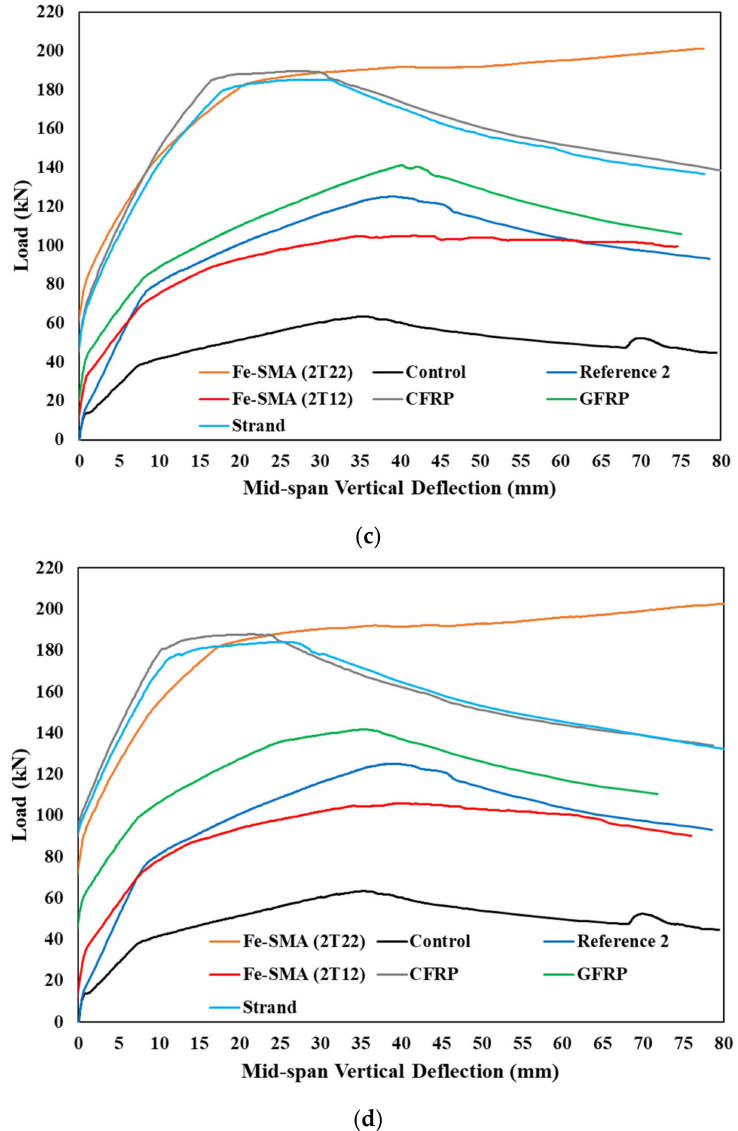
Figure 16. Effect of varying strengthening material types on the load-deflection behavior of beams subjected to different pre-stressing levels: ( a ) non-pre-stressed, ( b ) 20% pre-stressing level, ( c ) 40% pre-stressing level, ( d ) 60% pre-stressing